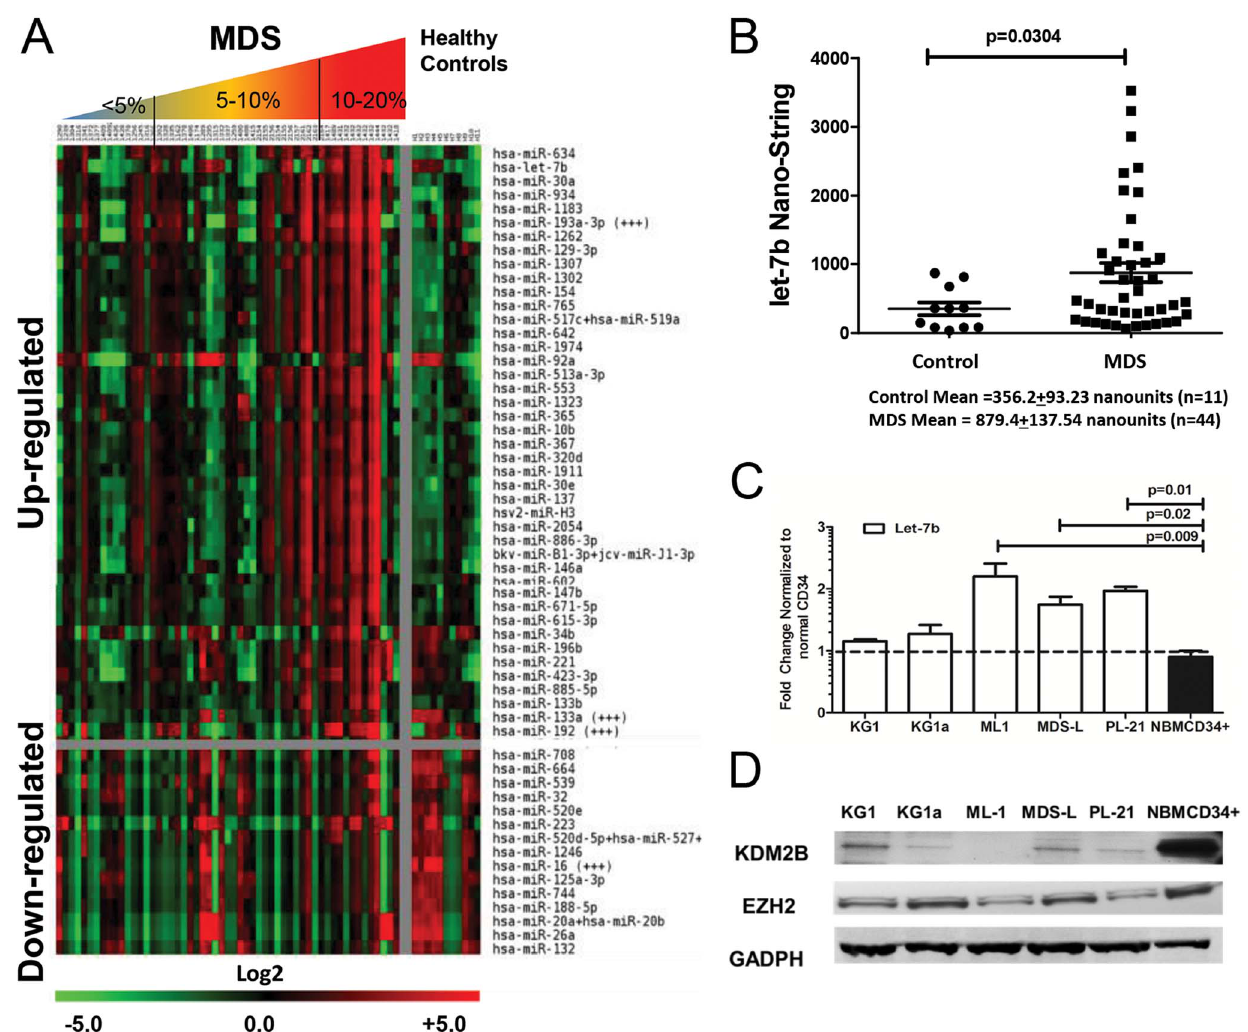
Figure 1. CD34 + marrow cells from MDS patients showing distinct patterns of up-regulated and down-regulated miRs in comparison to healthy controls. A ) Heatmap of the top 43 up-regulated and the top 15 down-regulated miRs in CD34 + marrow cells from healthy controls (n=11) and patients with MDS (n=44) ordered by , 5% blast (n=14), 5–10% (n=17) and 10–20% blasts (n=13), as determined by nanostring micro-array analysis (two replicates). Expression levels were calculated by averaging the duplicate spots for each miR. MiRs are listed in order of significance (top up-regulated vs. top down-regulated) determined by SAM analysis, displayed is log 2 value. Higher levels of miRs are displayed in red, lower levels in green. B ) NanoString Array data of individual samples, shows increased expression of let-7b in MDS (n=44) compared to CD34 + cells from health controls (n=11; mean 6 SEM=356.2 6 93.23 versus 879.4 6 137.54, p=0.03 in patients with MDS, Student t-test). C ) Let-7b expression (by RQ-PCR) in myeloid cell lines ML-1, PL-21, MDS-L, KG1 and KG1a compared to primary marrow cells from a pool of 6 healthy donors (NBMCD34 + )(mean 6 SEM of 3 experiments, Fold changes, normalized to expression in healthy donors; Student t-test). D ) KDM2b and EZH2 expression (by western blot) in the same cell lines. The lowest levels of KDM2B and EZH2 are seen in ML-1 and PL-21 cells, the cells with the highest levels of let-7b. GADPH served as control (The blots show one of 3 similar experiments).